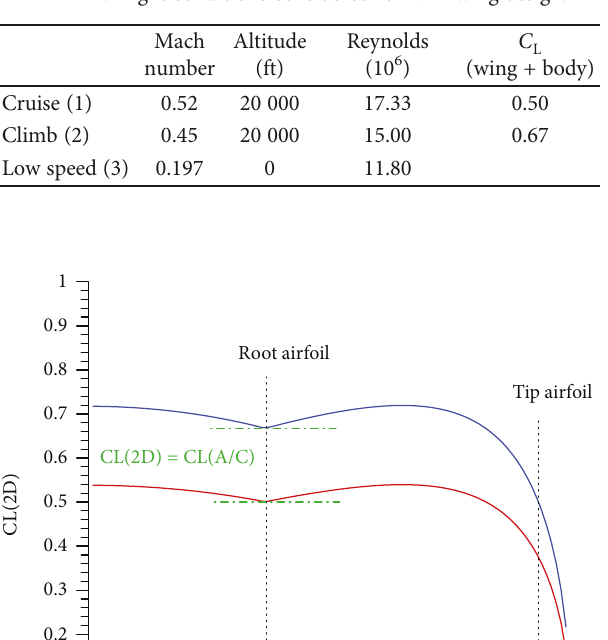
Table 1: Flight conditions considered for NLF wing design.